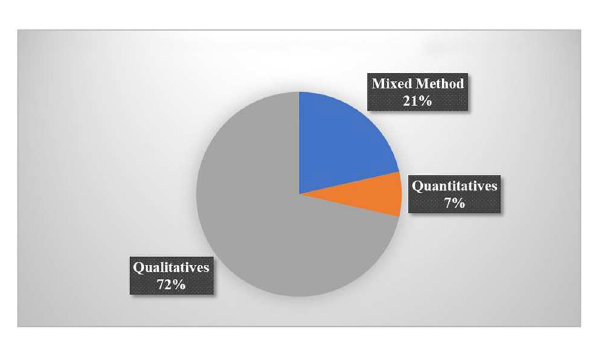
FIGURE4 The number of articles based on the research method used.